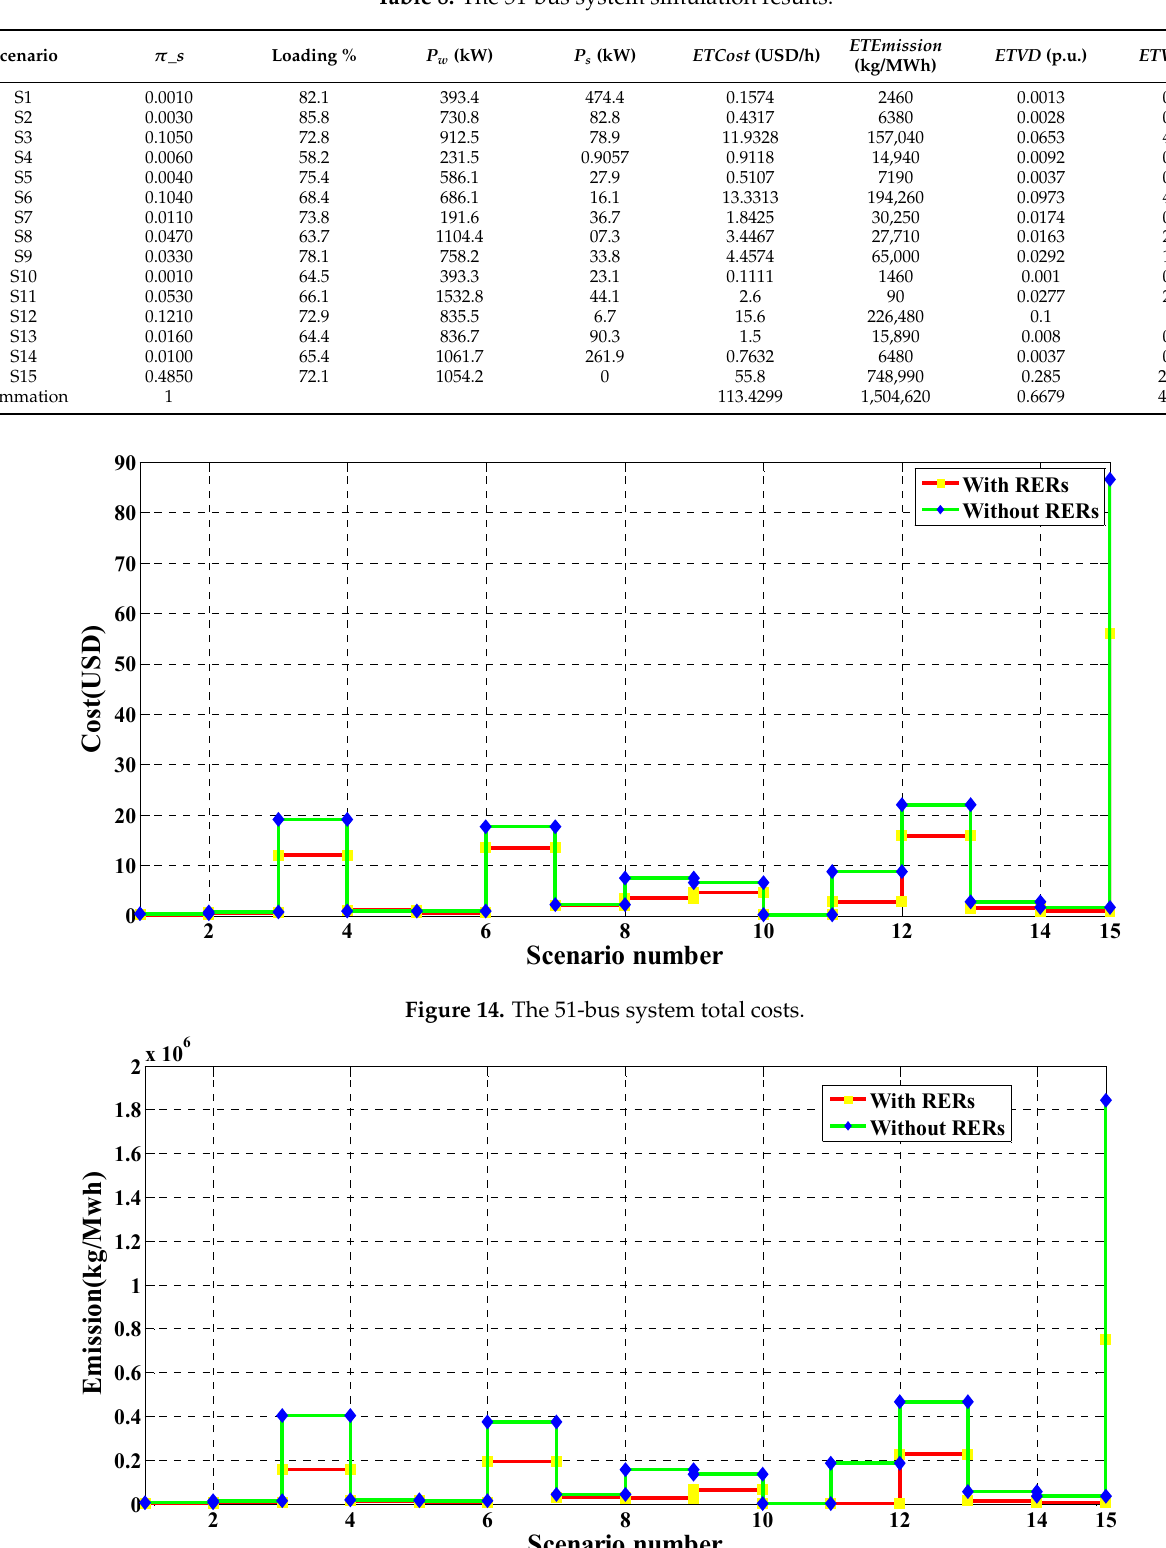
Figure 15. The 51-bus system emissions.